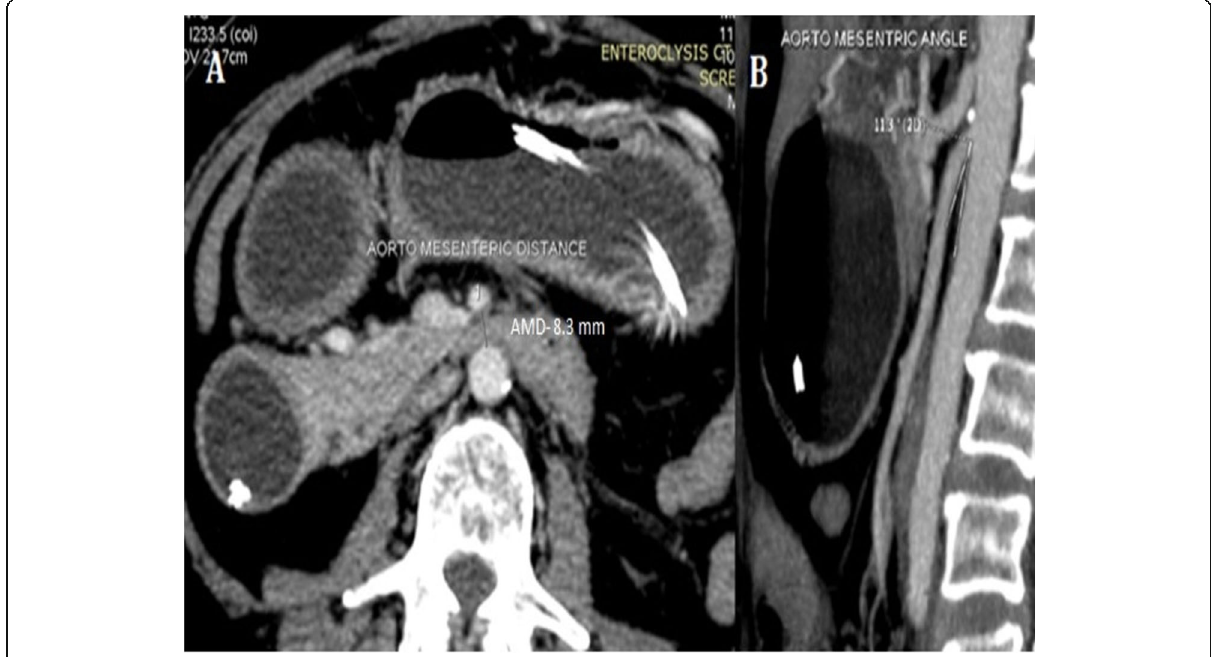
Fig. 4 Same patient as in Fig. 3 with SMA syndrome. Axial view ( a ) and sagittal view (b ) of the abdomen in the late arterial phase shows reduced